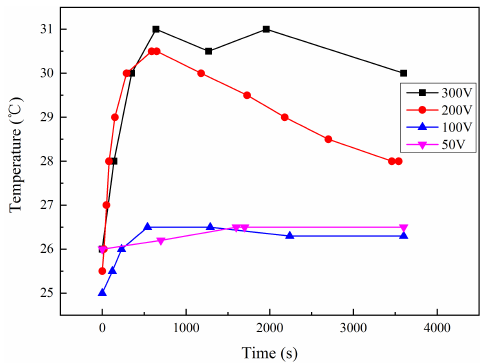
Figure 4. Local soil temperature-time transient 1 cm away from the coupon under HVDC